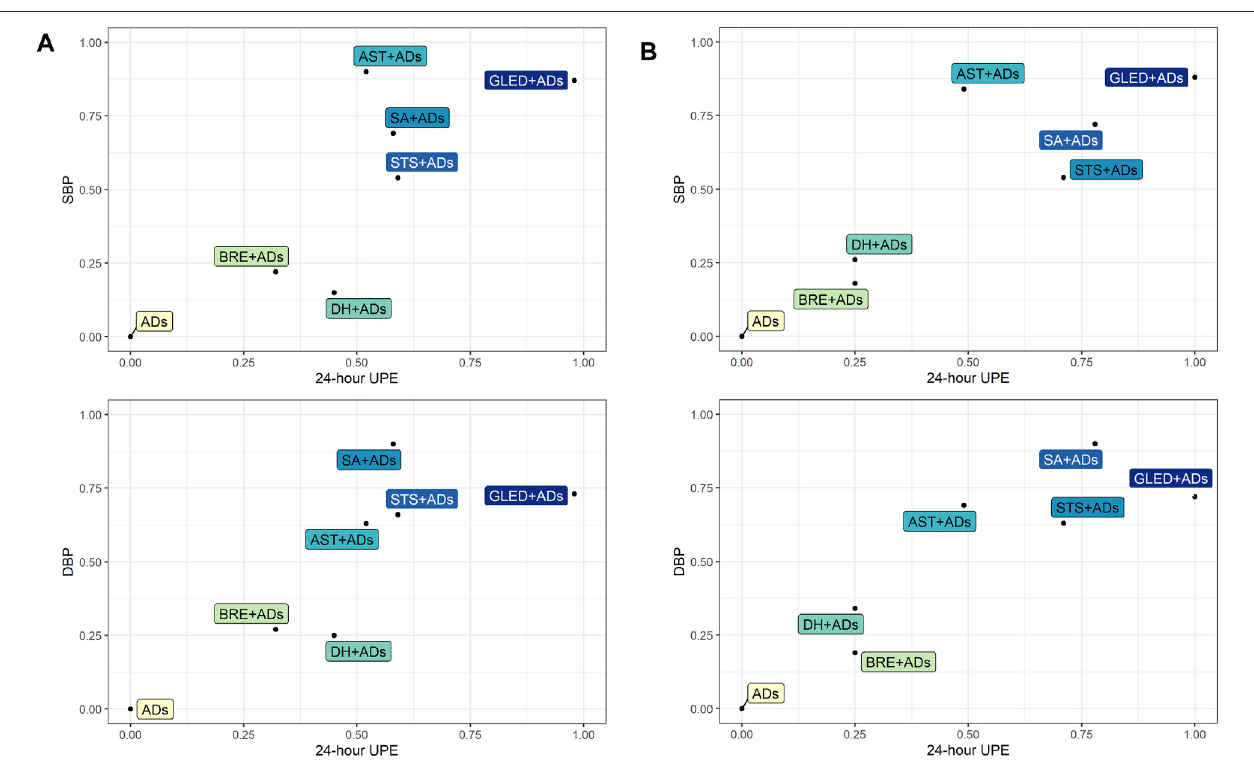
FIGURE 5 | Biplots for primary outcomes. ADs: antihypertensive drugs; SA: salvianolate; DH: danhong; BRE: breviscapine; AST: astragalus; STS: sodium tanshinone IIA sulfonate; GLED: ginkgo leaf extract and dipyridamole. (A) : Original network analysis results; (B) : Sensitivity analysis results.